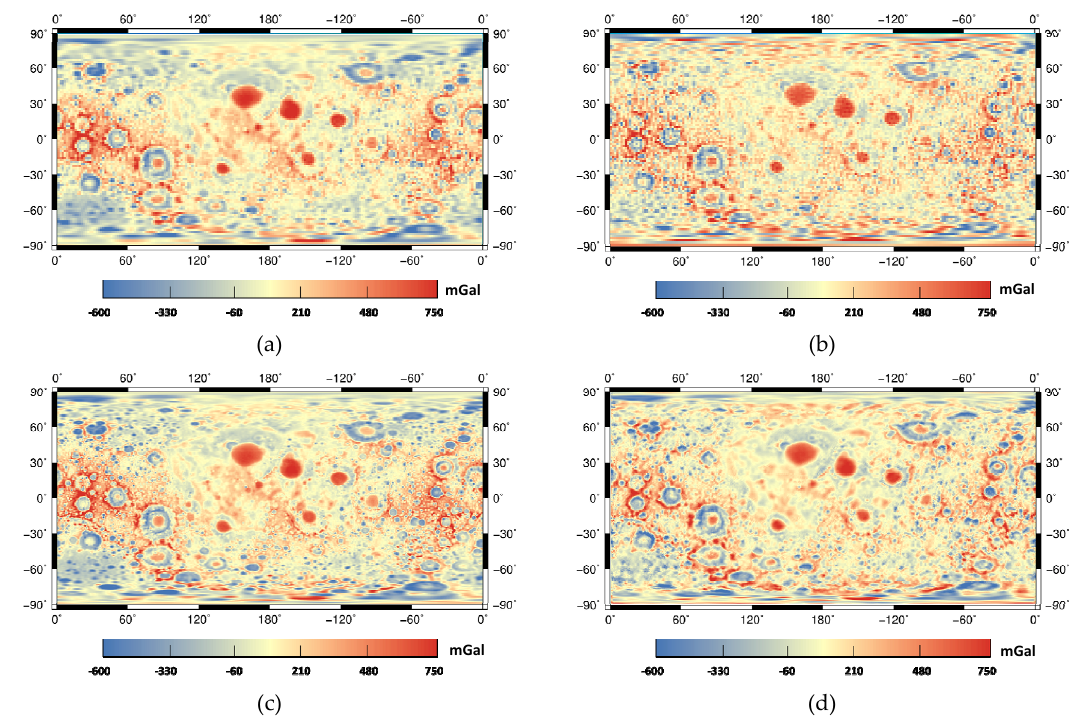
Figure 6. Visual comparison of SELENE and GRAIL. ( a ) 100-degree GRAIL; ( b ) 100-degree original SELENE; ( c ) 200-degree GRAIL; ( d ) 200-degree reconstructed SELENE.